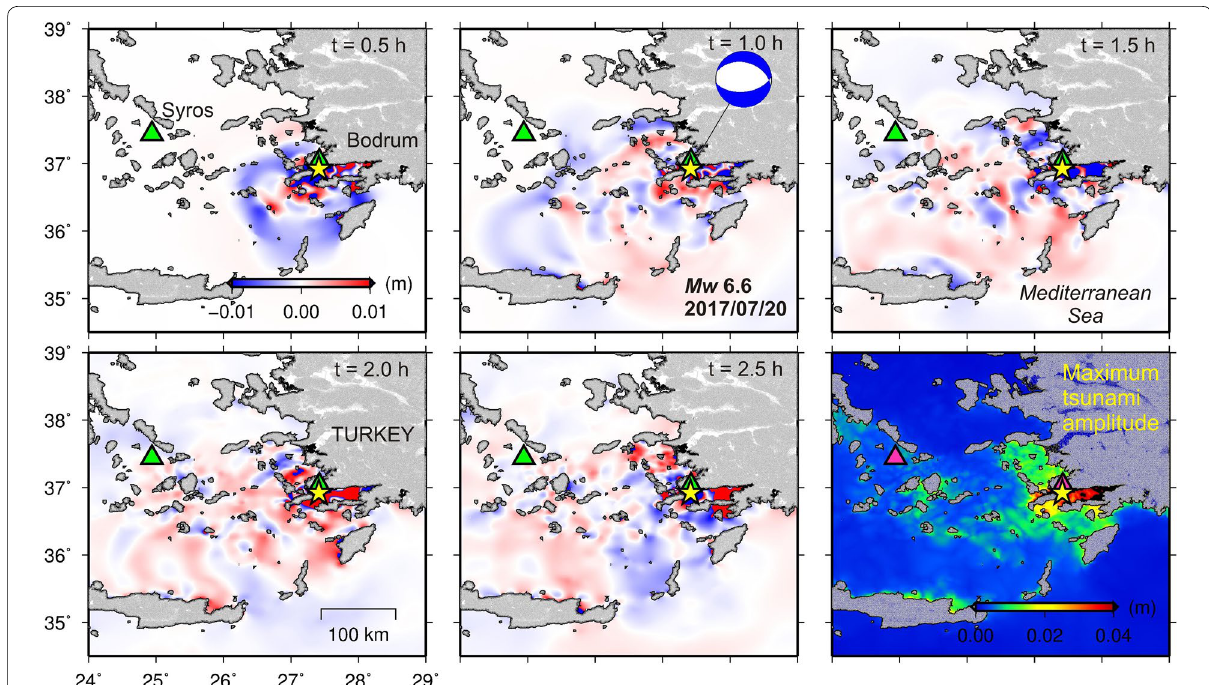
Fig. 5 Simulated snapshots at different times (the first five panels) and the maximum tsunami amplitude (the panel at bottom-right) for the 20 July 2017 Bodrum–Kos tsunami. These results are based on